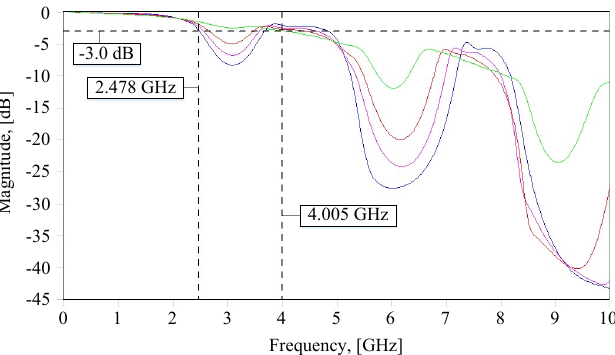
Fig. 6. Magnitude frequency response of the meander line, when b = 1.45 mm (blue); b = 1.65 mm (pink); b = 1.85 mm (red); b = 2.3 mm (green); Z 0 = 50 Ω . In other words, the capacity of the unit of length decreases.